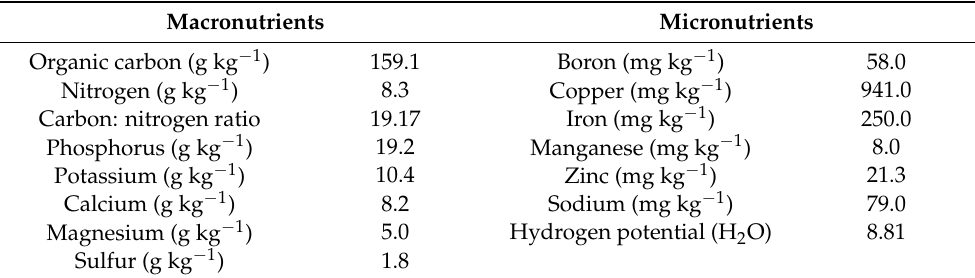
Table 4. Chemical characterization of the bovine manure used in the experiment. Macronutrients Micronutrients Organic carbon (g kg − 1 ) 159.1